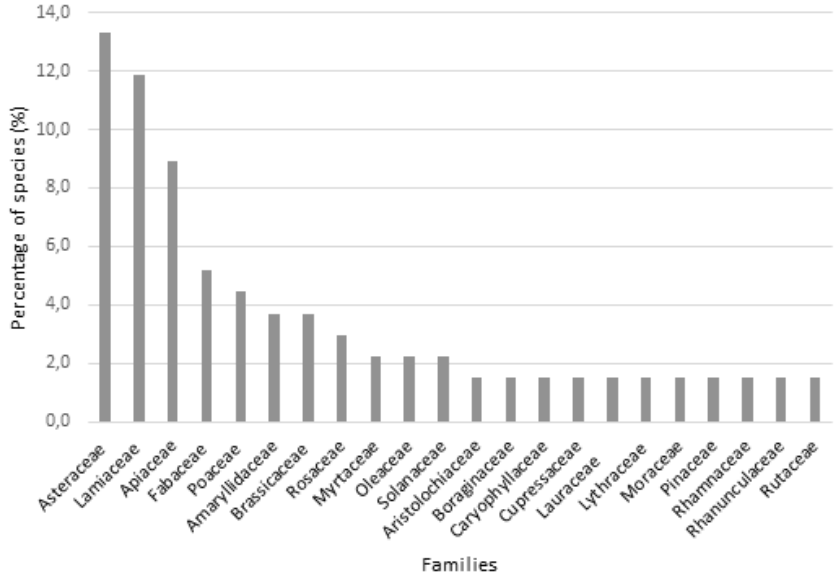
Figure 2. Number of medicinal plant species by families (32 families with one species each are not represented).